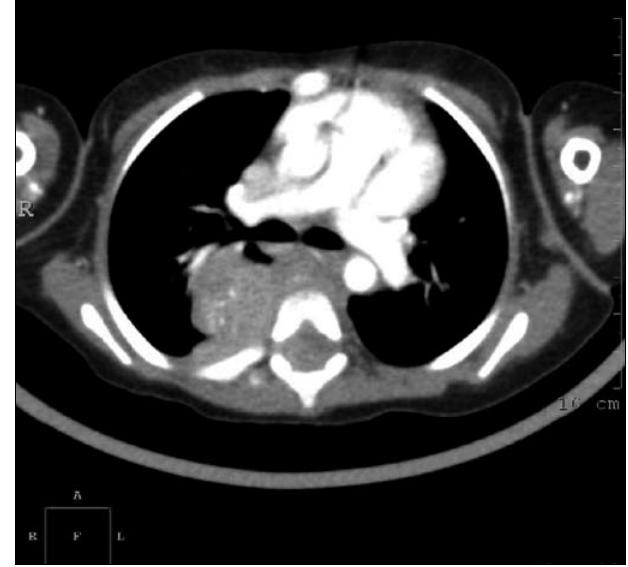
Fig. 3. Post-contrast axial chest CT at the level of the mediastinum demonstrates a poorly enhancing, predominantly right sided, posterior mediastinal mass with calcification and right neural foramen